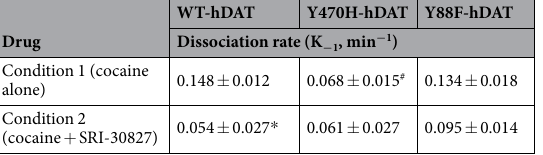
Table 5. Effects of SRI-30827 on cocaine-induced [ 3 H]WIN 35,428 binding dissociation in WT and mutated hDAT. Data are calculated as a percentage of [ 3 H]WIN 35,428 binding dissociation rate in response to cocaine with or without SRI-30827 (50 nM) addition followed by nonlinear regression analyses using a single component dissociation model. Data are presented as mean ± S.E.M. of dissociation rate values from 4–7 independent experiments performed in duplicate. * p < 0.05 compared with the respective condition 1